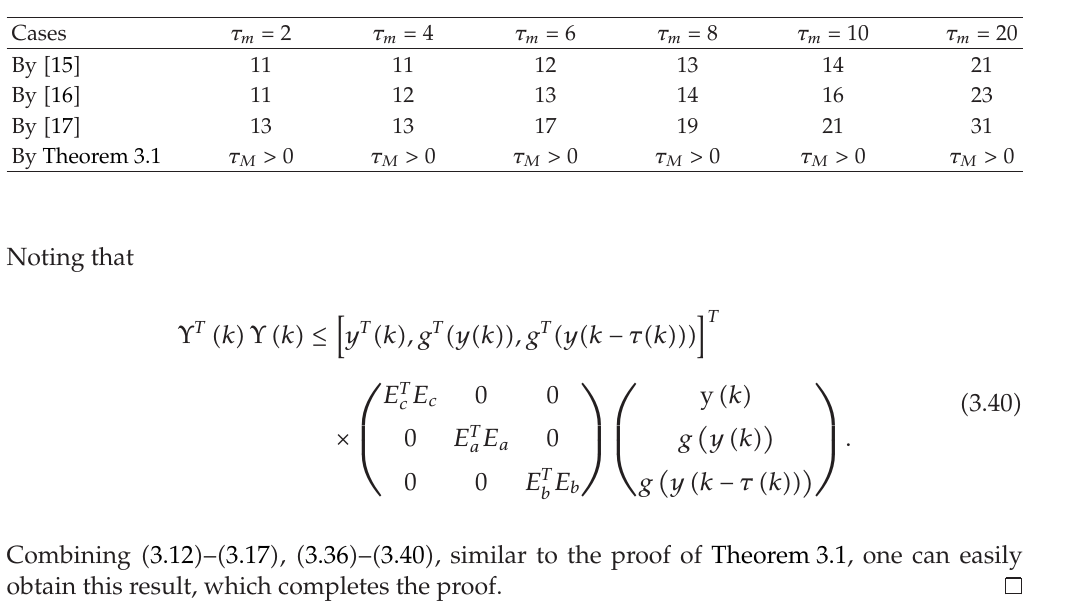
M for given τ m